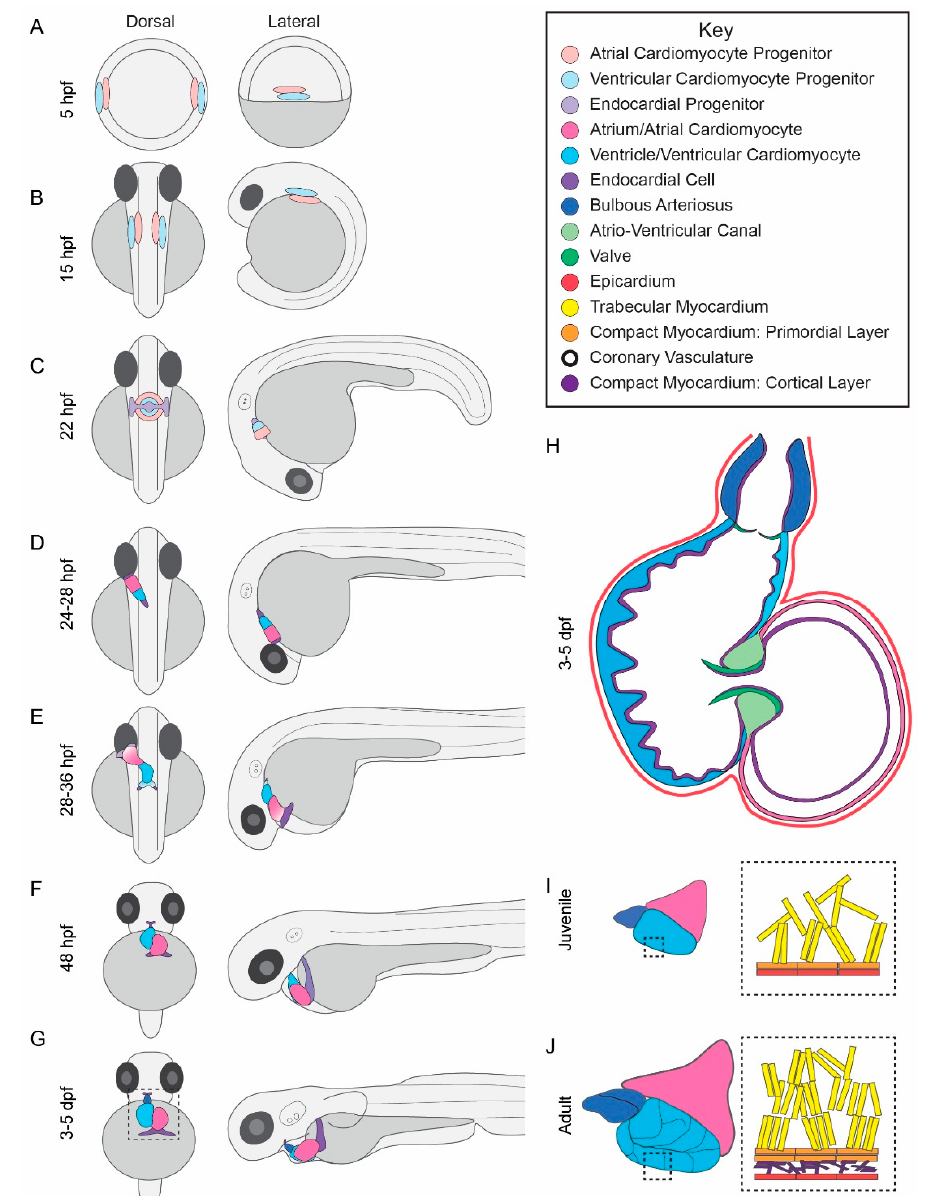
Figure 2. Zebrafish heart development. ( A – G ) Lateral and dorsal views of heart development from 5 hpf embryos to 5 days post fertilization (dpf) larvae. ( A ) Cardiac progenitors are located at the lateral margin with the ventricular progenitors more closer to the margin than the atrial progenitors at 5 hpf; (B ) Cardiac progenitors migrate bilaterally to the anterior lateral plate mesoderm by 15 hpf; ( C ) By 22 hpf, cardiac progenitors and developing endocardial cells have fused to form the cardiac disk which begins regular contractions between 22 and 24 hpf; ( D ) From 24 to 28 hpf, the disk elongates into the linear heart tube and begins leftward migration; ( E ) The linear heart tube continues migrating leftward and begins looping. Concurrently, from 28 to 36 hpf, second heart field cells are added to the arterial and venous poles, illustrated by shading; ( F ) By 48 hpf, the two chambered heart has formed; ( G ) The bulbous arteriosus forms at the outflow tract; ( H ) Cross-sectional view of the heart from 3 to 5 featuring trabeculae located primarily in the outer ventricle wall, cardiac valves, and covering of the heart by the epicardium; ( I ) Between larval and juvenile stages, the atrium and ventricle rotate such that the atrium is dorsal to the ventricle. The inner topology is complex and features a spongy trabecular myocardium and outer compact myocardium called the primordial layer; ( J ) Additional features of the adult heart are coronary arteries which feed the ventricle and expansion of the compact myocardium by addition of a cortical layer of CMs.